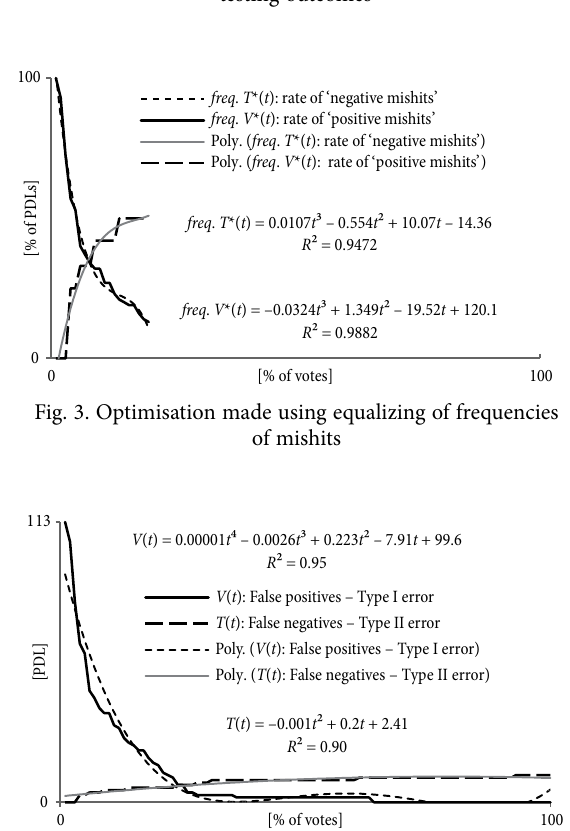
Fig. 2. Frequencies of the multiple hypothesis testing outcomes